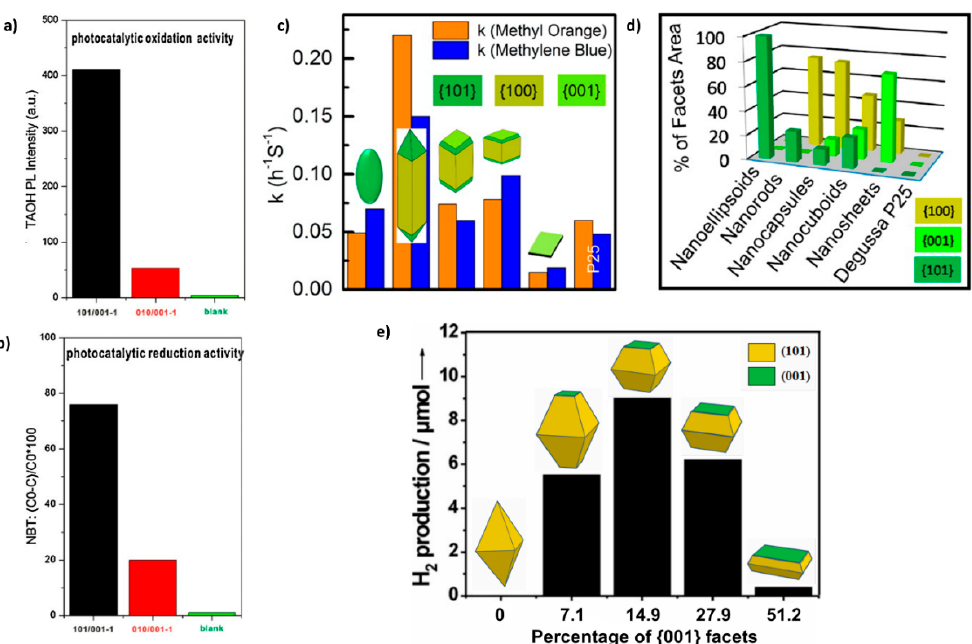
Figure 5. The intensity of PL signal associated with the reaction of TA (terephthalic acid) with • OH resulting in the formation of TAOH (2-hydroxy terephthalic acid ( a ), the percentage of reduced NBT (nitroblue tetrazolium) from the reaction of NBC with O 2 •− ( b ). Reprinted with permission from ref. [111] Dependence of the rate constant of MO and MB degradation on different shapes of TiO 2 nanocrystals ( c ), relative % of exposed facets area for the examined shapes ( d ). Reprinted with permission from ref. [98]. Photocatalytic H 2 production using TiO 2 nanocrystals with different amount of highly reactive {001} facets after 6 h irradiation ( e ). Reprinted and modified with permission from ref. [15].